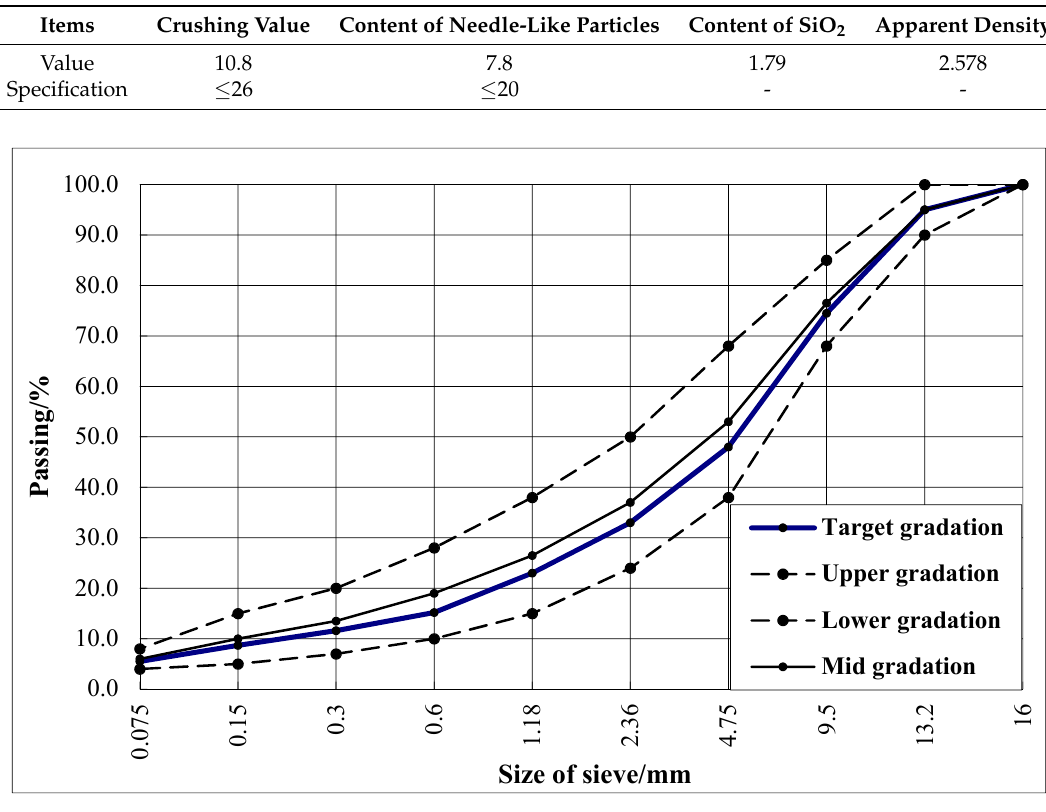
Table 2. Chemical and physical properties of aggregates.